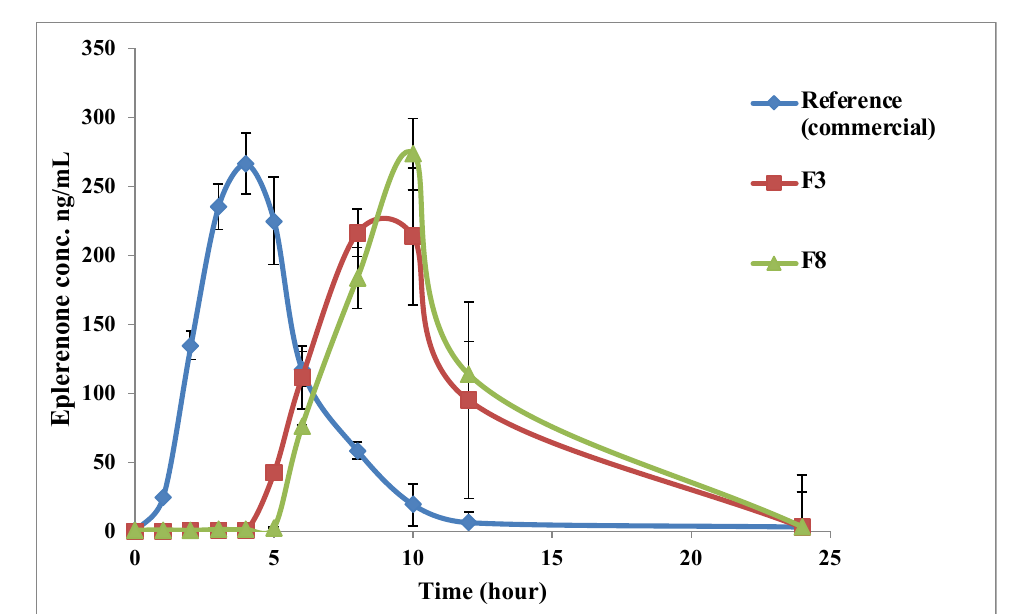
FIGURE 7 - Mean Eplerenone plasma concentration (ng/mL)/ time curve ± SD in subjects receiving commercial and tested tablets. *F3: contains 50 % PEO WSR in the coating layer, F8: contains 22 % Carbopol 71 G in the coating